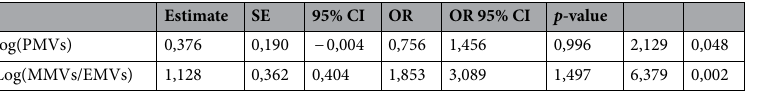
Table 2. Association between cell derived MVs or exosomes with a worst RB grade during the post blood sampling follow-up, according to logistic model. All the analyses were adjusted on age, prescribed radiation dose, adverse treatment, the delay between the radiotherapy and the blood sampling as well as the toxicity grade at the blood